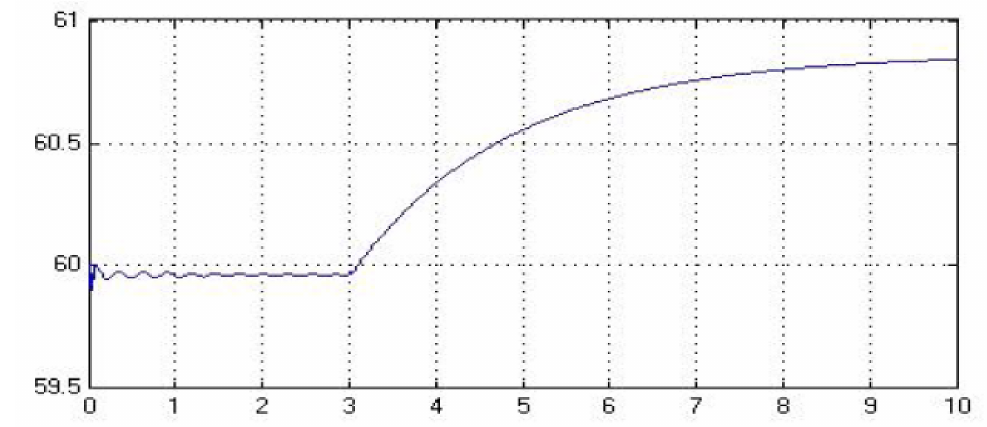
Figure 10. PMU-based islanding detection using frequency data [57].